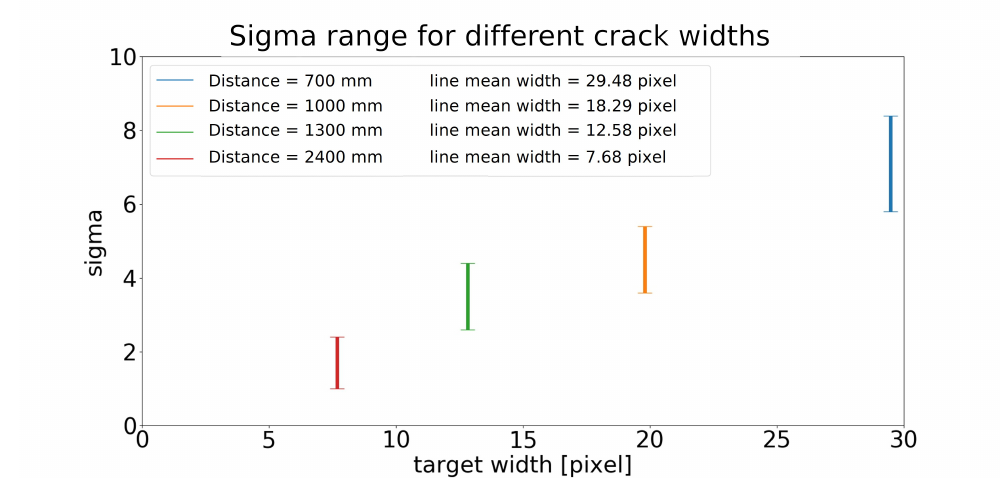
Figure 23. Dispersion of the values at each distance, normalized to the equivalent pixel width of the target line.